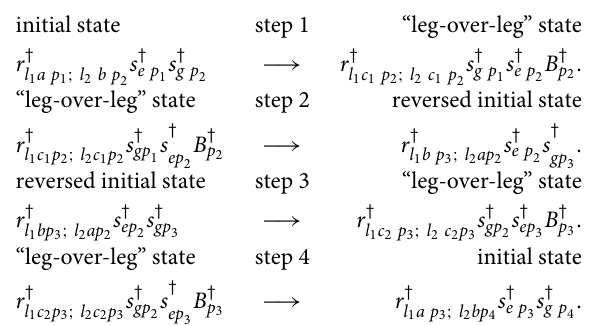
1 ; the initial state is (1a, 2b). =